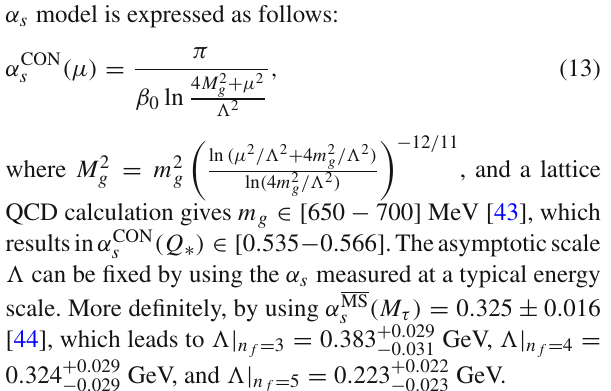
Eq. (12), we obtain Q ∗ = 0 . 250 GeV, which is close to the QCD asymptotic scale.